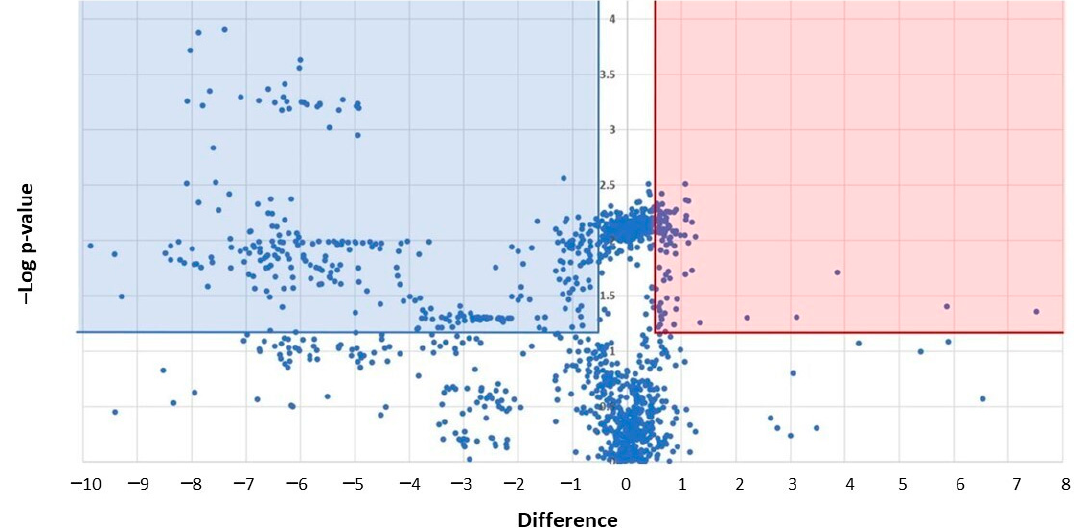
Figure 9. LC-MS/MS analysis of platelet-derived EVs obtained from CRC patients, and healthy controls revealed 208 significantly modulated proteins. Platelet-derived medium-size EVs were obtained from thrombin-stimulated washed platelets from six CRC patients and six healthy controls, matched for sex and age. MaxQuant software (version 1.5.0.30) was used to quantify EV proteins (after lysis, digestion, and purification) that LC-MS/MS identified. The 1429 proteins identified in the data set are shown in the Volcano plot. The log10 ( p -value) and the “difference” values (CRC-controls) are reported on the y -axis and x -axis, respectively. The 208 significantly modulated proteins are shown: the proteins downregulated in CRC (blue square) and the upregulated in CRC (red square) vs. controls ( p < 0.05, FDR 0.05, Difference > 0.4). The list of the 208 proteins that were significantly modulated is shown in Figure 10. The blue bars represent the 119 downregulated proteins in platelet-derived mEVs of CRC patients vs. HS; the red bars are the 89 significantly upregulated proteins in CRC compared to HS (Figure